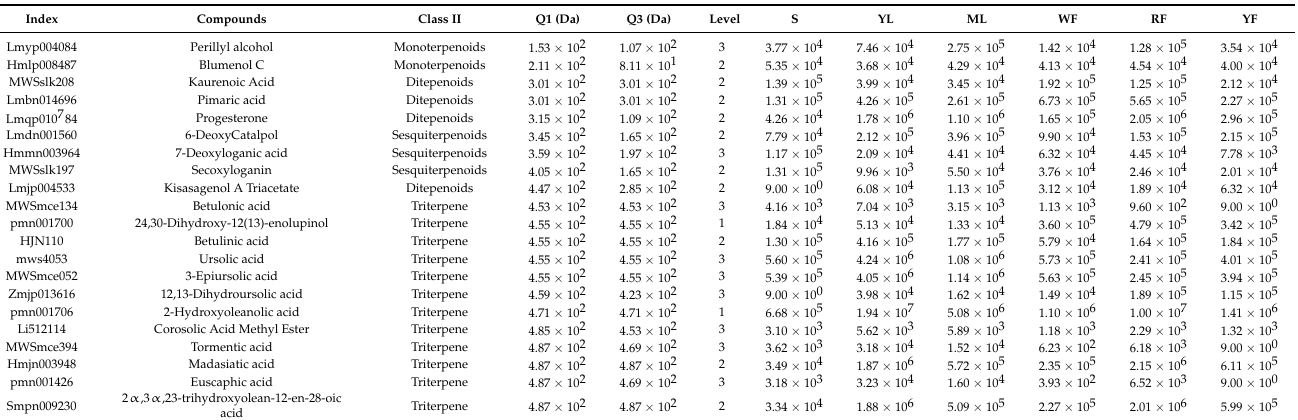
Figure 1. Metabolic analysis of various plant parts in sacred lotus. ( A ) Sample morphology of various plant parts. ( B ) Sample cluster map. The horizontal is the sample name, the vertical is the metabolite information, and the different colors are the values obtained after the relative content standardization process. Table 1. Relative content of terpenoids.